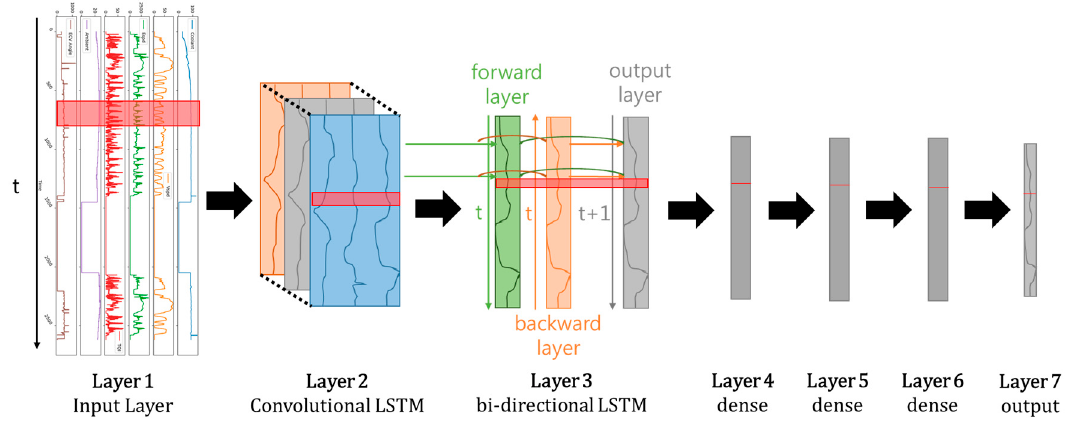
Figure 6. Description of the convolutional long short-term memory (ConvLSTM) architecture. For time-series forecasting, ConvLSTM and bidirectional long short-term memory (LSTM) were stacked.